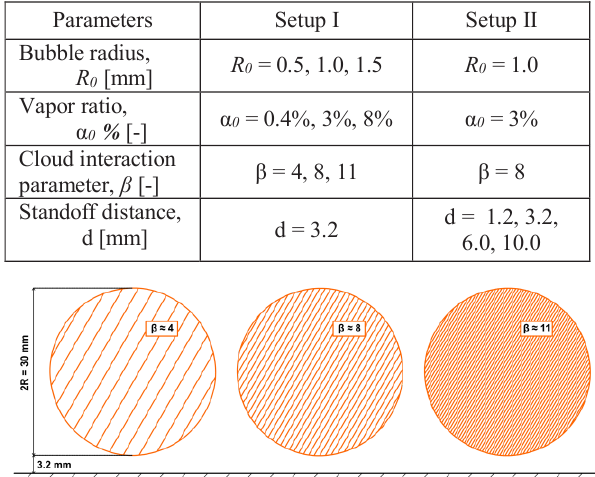
Table 1: Properties of the designed setups